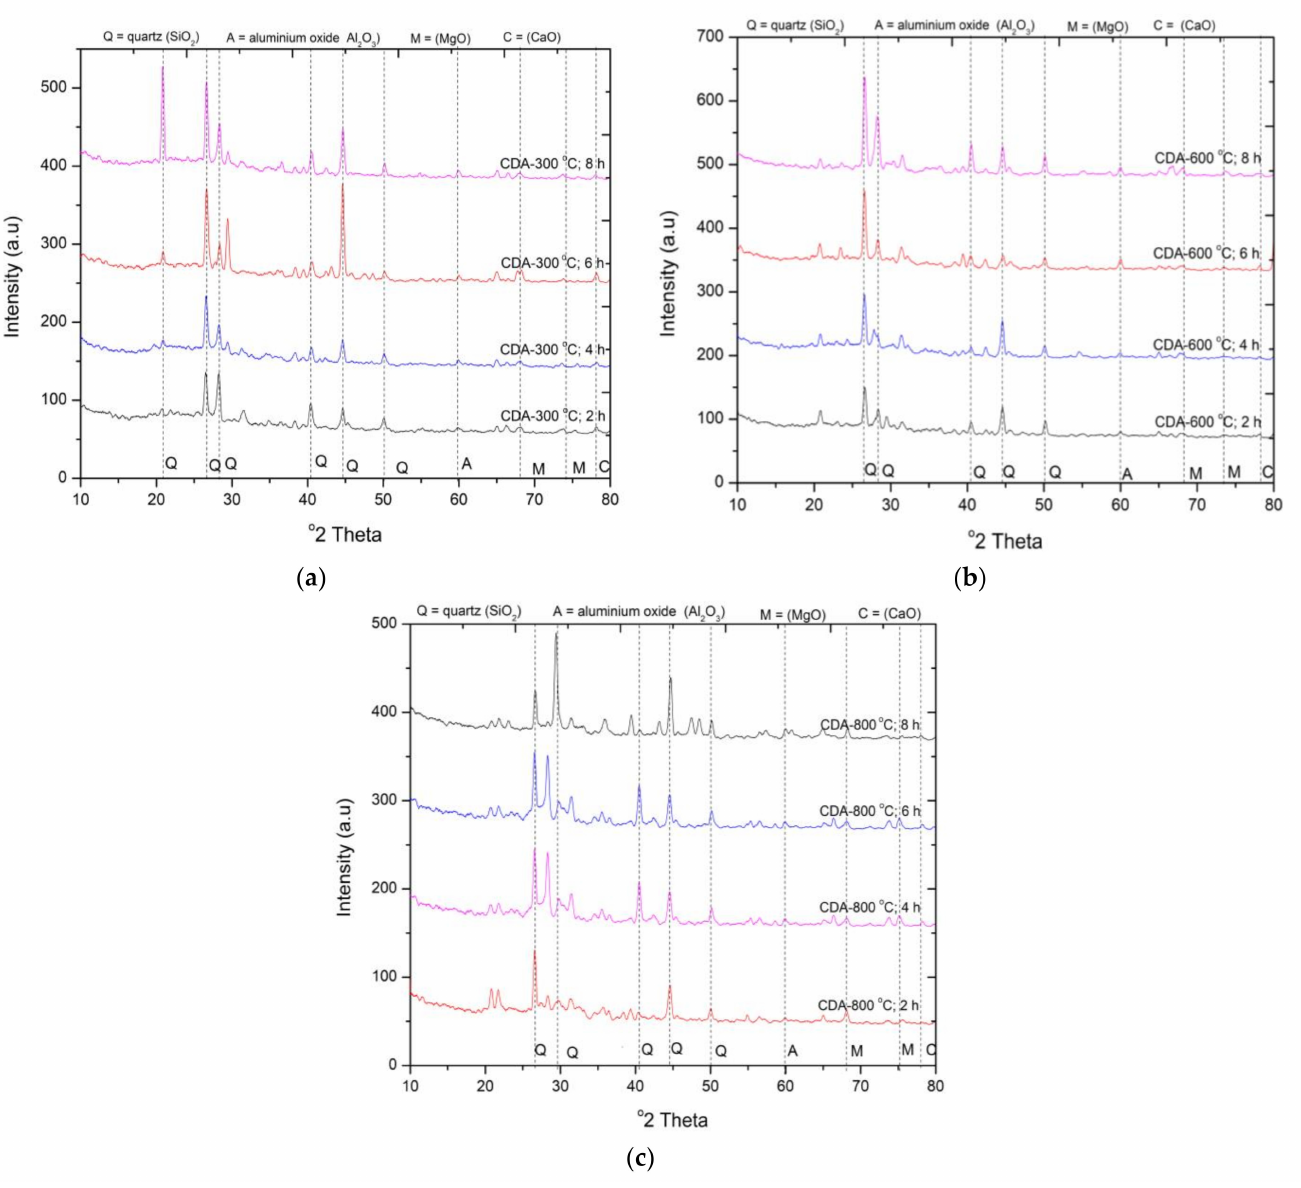
Figure 3. XRD pattern of rice CDA calcinated at ( a ) 300 ◦ C ( b ) 600 ◦ C and ( c ) 800 ◦